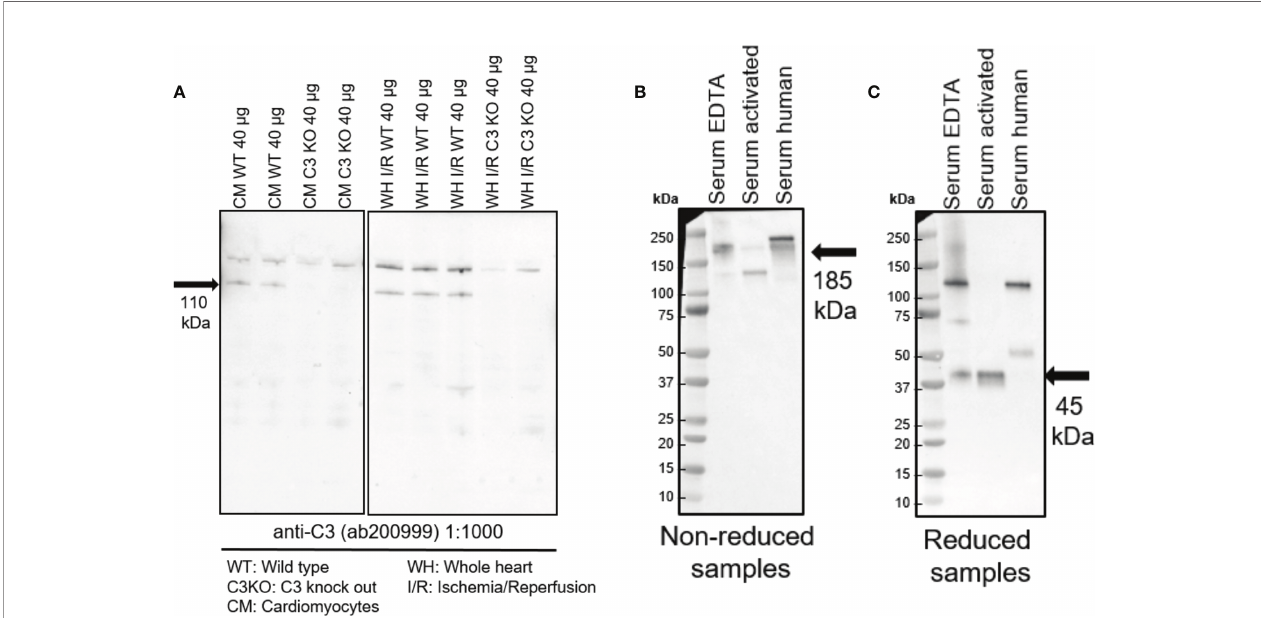
FIGURE 1 | Western blots showing expression of intracellular C3 in the heart. (A) Equal amounts of cardiomyocytes and heart tissue were loaded in a 4-20% gradient gel. A band at 110 kDa band was observed in cardiomyocytes (CM) and whole heart tissue lysate from ischemia-reperfused hearts (WH I/R) from wild type (WT) mice, which was not present in the complement component 3 knock out (C3KO) samples. Serum and activated serum from WT mice and human serum were tested at both reduced (B) and non-reduced conditions (C) . A band at 185 kDa (non-reduced) and 110 kDa (reduced) corresponding to intact a -chain of C3 was observed in WT serum and human serum (B) . Cleaved C3 a -chain (45 kDa) was observed in the reduced samples (C)